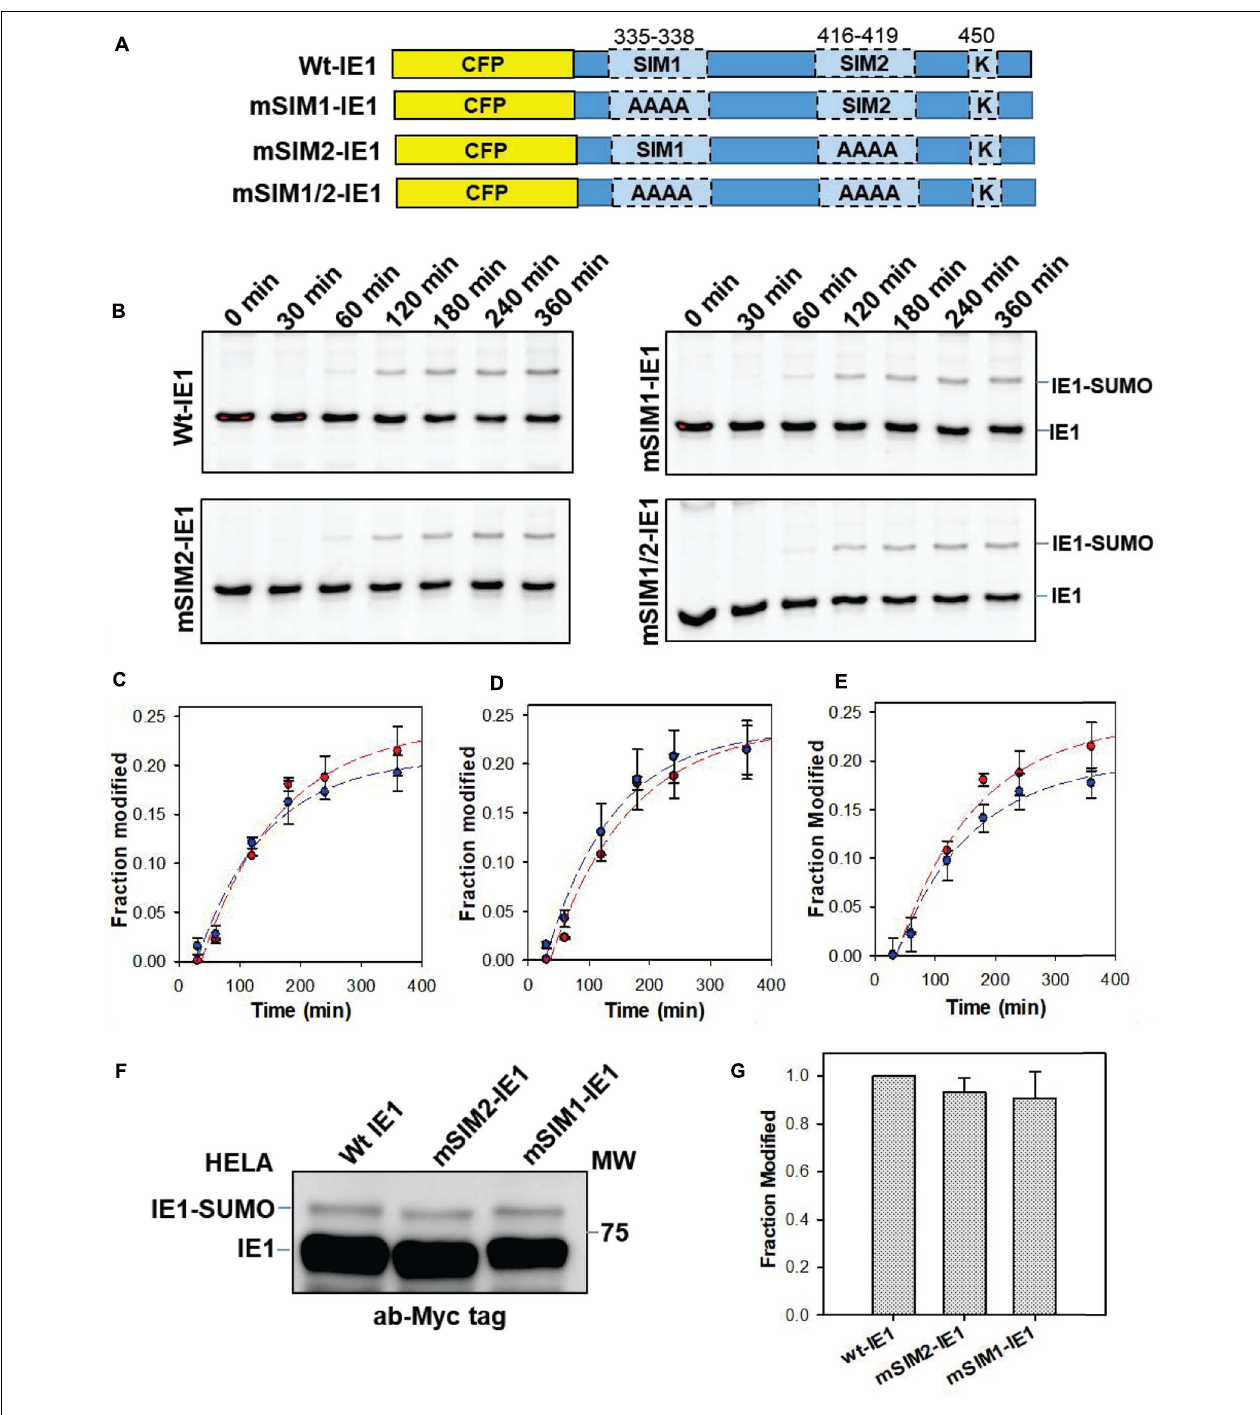
FIGURE 2 | Effect of SIMs on SUMOylation of IE1. (A) The C-terminal fragment of IE1 (325–460, containing SIMs and SUMOylation site) was cloned with CFP. Schematic representations of SIM-mutants of IE1 are given. (B) IE1 (wt or mutants as mentioned) was SUMOylated in vitro . The reaction was stopped at given time points. The SUMOylation reaction was resolved on the SDS-PAGE gel and imaged for CFP. (C–E) The fraction of the IE1 ∼ SUMO was quantified by ImageJ. Fraction modification is plotted against time. (C) represents wt and mSIM1-IE1, (D) represents wt and mSIM2-IE1, and (E) represents wt and mSIM1/2-IE1 (red is wt, and blue is the mutant). (F) HeLa cells were transfected with Myc-IE1 and SUMO1. Cells were lysed 48 h post-transfection were separated on the SDS page, and blotted with anti-Myc. The lower band indicates Myc-IE1, while the higher molecular size band indicates IE-SUMO. (G) IE1-SUMOylation in HeLa was repeated, and fraction SUMOylation was